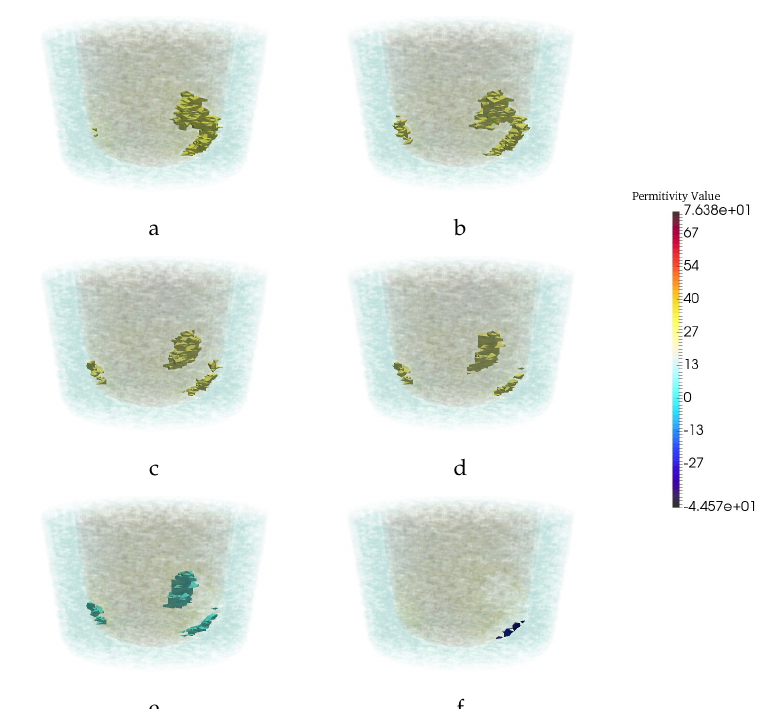
Figure 5. CSI reconstructions at four remaining frequencies for the same example as in Figure 4 and resulting images after intersecting images thresholded at 85% of the maximum reconstructed permittivity. ( a – d ) The real part of CSI reconstructions at 1.2, 1.3, 1.4, and 1.5 GHz. ( e ) Intersection of real part of CSI reconstructions. ( f ) Intersection of imaginary part of CSI